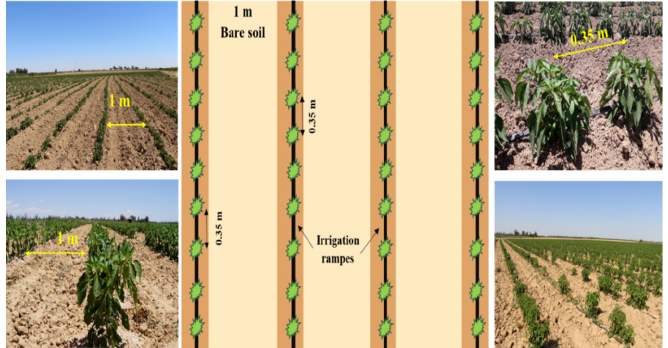
Figure 5. Pepper reference field architecture: delineation of the bare soil and vegetation parts, where the green spots represent pepper plants and the black lines represent the irrigation tape, based on ground truth scaling and illustrations.